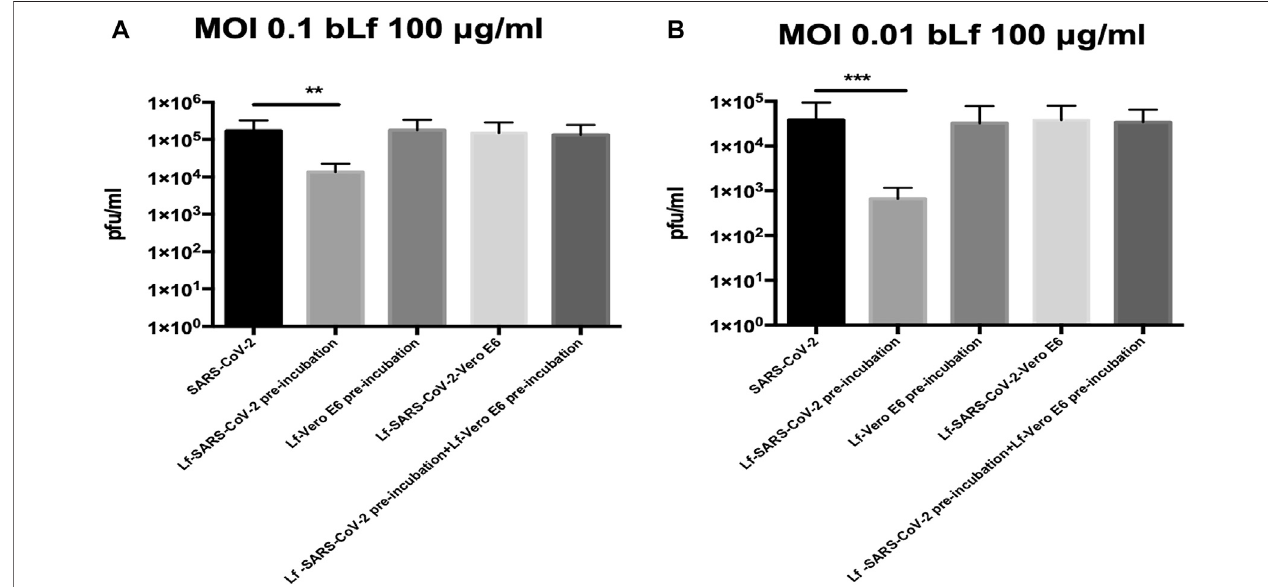
FIGURE1 | Plaque-forming units (pfu)/ml ofSARS-CoV-2observed inVeroE6cells infected at multiplicityof infection (MOI) of0.1 (A) and 0.01 (B) inthe presence or absence of 100 μ g/ml of bovine lactoferrin (bLf) according to the following experimental procedures: i) control: untreated SARS-CoV-2 and Vero E6 cells; ii) bLf preincubated with SARS-CoV-2 inoculum for 1 h at 37 ° C before cell infection; iii) cells preincubated with bLf for 1 h at 37 ° C before SARS-CoV-2 infection; iv) bLf added together with SARS-CoV-2 inoculum during the adsorption step; and v) virus and cells separately preincubated with bLf for 1 h at 37 ° C before infection. Data represent the mean values of three independent experiments. Error bars: standard error of the mean. Statistical signi fi cance is indicated as follows: **: p < 0.001, ***: p < 0.0001 (unpaired student ’ s t test).